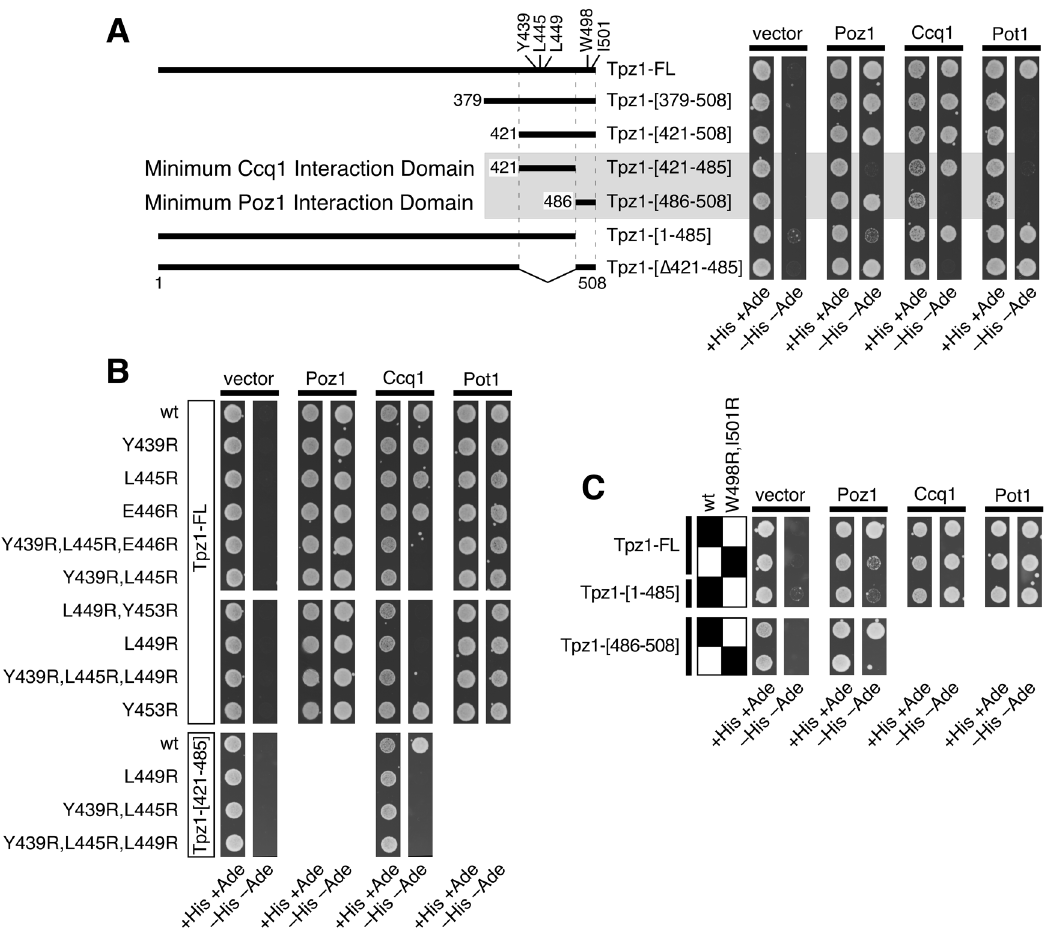
Figure 2. Determination of domains and amino acid residues critical for mediating Tpz1-Ccq1 and Tpz1-Poz1 interaction in Y2H assays. ( A ) Identification of minimum Tpz1-Ccq1 and Tpz1-Poz1 interaction domains by Y2H assay. A positive interaction is identified by growth on 2 His 2 Ade plates. ( B ) Identification of mutations that specifically disrupt Tpz1-Ccq1 interaction by Y2H assay. Indicated mutations were tested in full length Tpz1 (Tpz1-FL) or the minimum Ccq1 interaction domain construct of Tpz1 (Tpz1-[421–485]). ( C ) Identification of mutations that specifically disrupt Tpz1-Poz1 interaction by Y2H assay. The effect of W498R,I501R mutation was tested in full length Tpz1 (Tpz1-FL) or the minimum Poz1 interaction domain construct of Tpz1